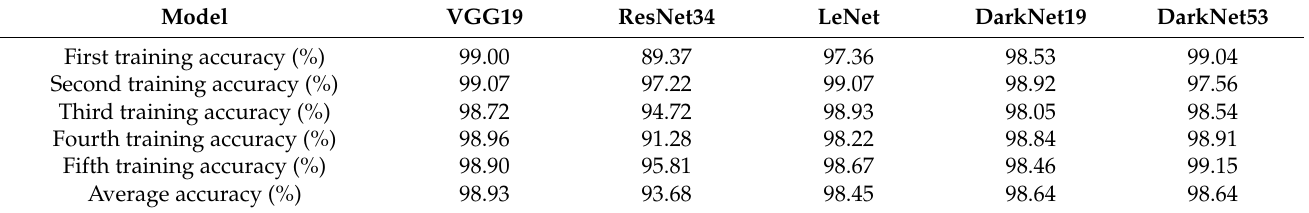
Table 1. Training accuracy for the VGG19, ResNet34, LeNet DarkNet 19 and DarkNet53 models. Model VGG19 ResNet34